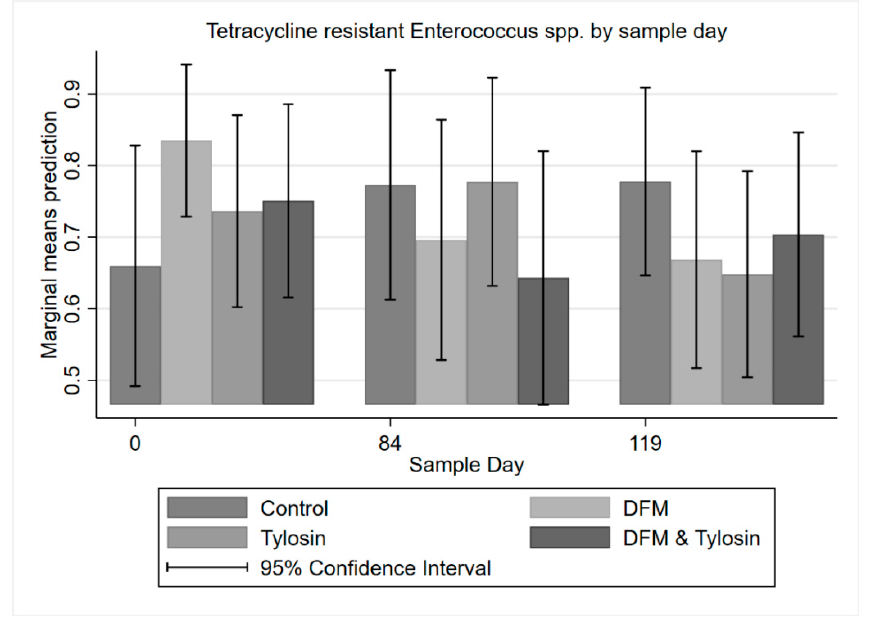
Figure 5. Marginal means with 95% confidence intervals of a 2 × 2 × 2 multi-level mixed logistic regression model, using factors of DFM, tylosin, and sample day on the binary outcome of tetracycline-resistant Enterococcus spp.